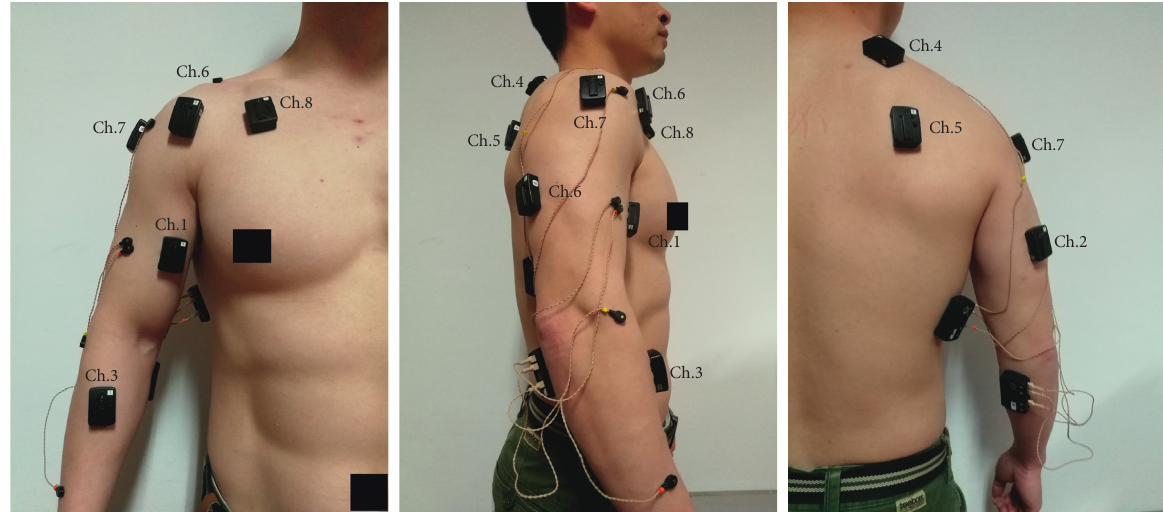
Figure 2: sEMG sensor arrangement (Ch1: BB, Ch2: TB, Ch3: BR, Ch4: TZ, Ch5: TM, Ch6: AD, Ch7: LD, and Ch8: PM).